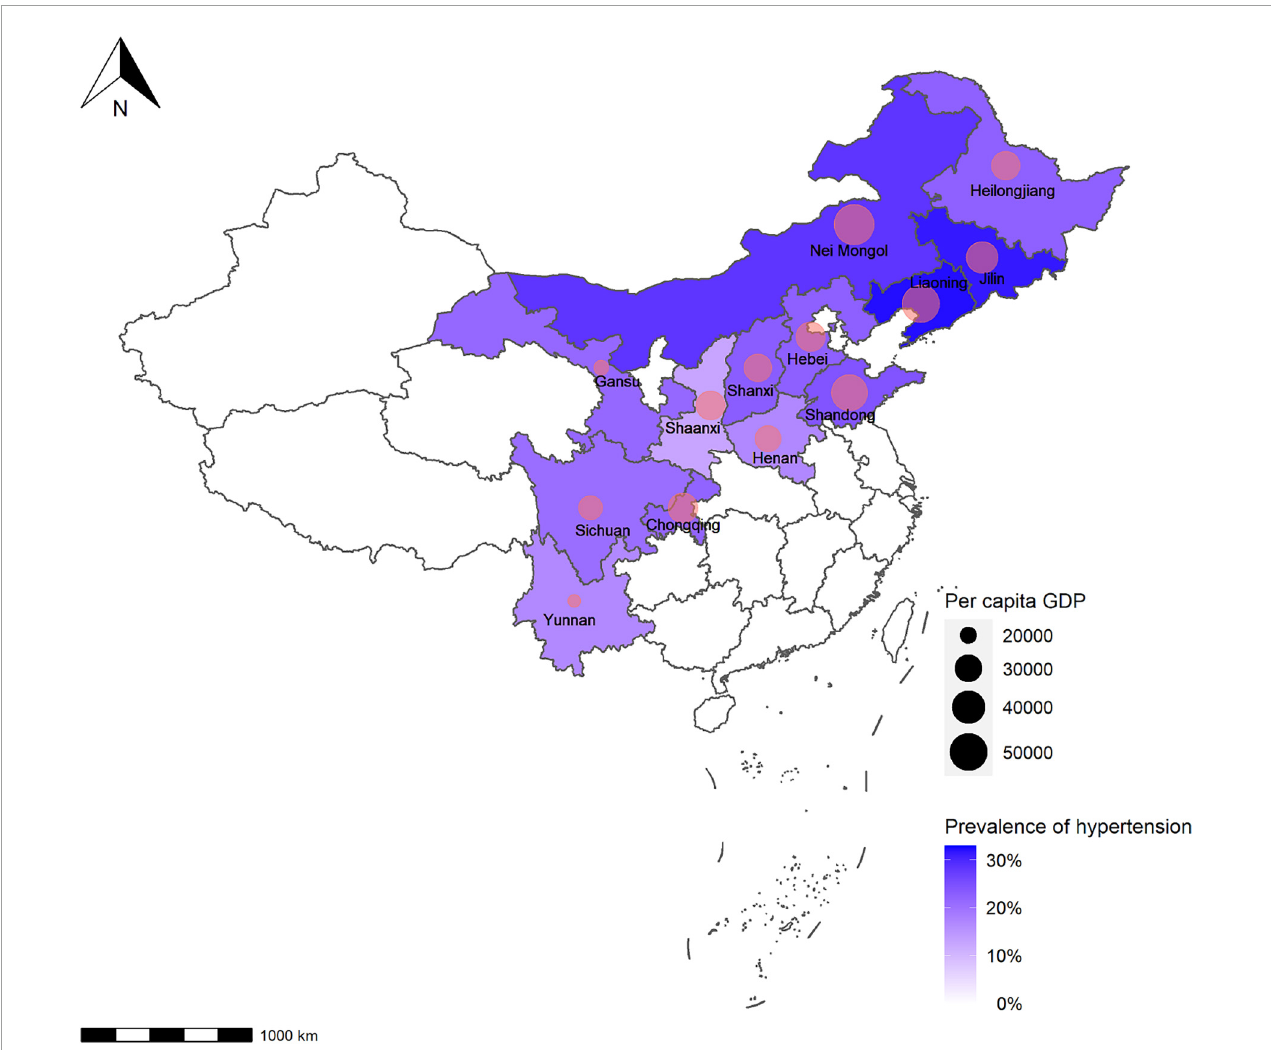
FIGURE5 Hypertension prevalence and per capita GDP at province level. The relationship between the per capita GDP and hypertension prevalence at province level was analyzed using Pearson’s correlation coefficient ( r = 0.6672, P = 0.0127). The prevalence was standardized by age and sex based on the 2012 China Statistical Yearbook. GDP, gross domestic